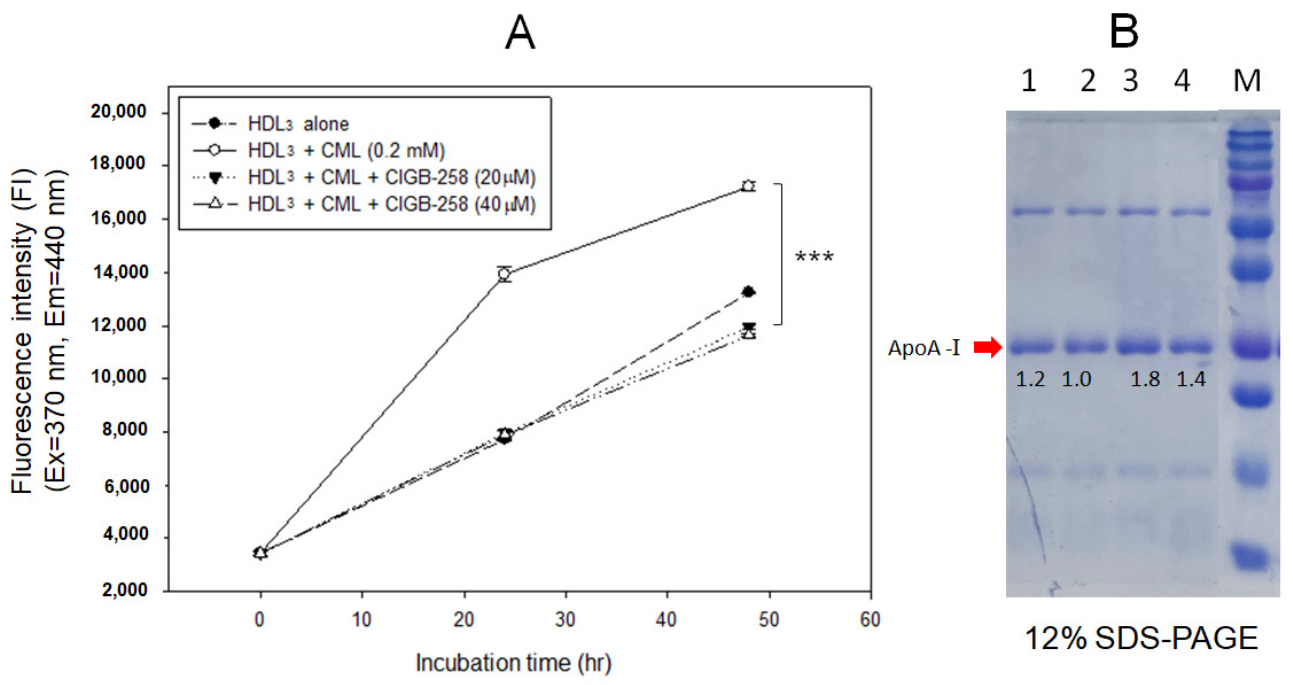
Figure 1. Glycation extent of high-density lipoproteins (HDL) by carboxymethyllysine (CML) in the presence and absence of CIGB-258. ( A ) Measurement of fluorescence intensity (Ex = 370 nm, Em = 440 nm) of HDL 3 to compare glycated extent during 48 h incubation. ***, p <0.001 between HDL 3 + CML and HDL 3 + CML + CIGB-258 (20 μ M). ( B ) Electrophoretic patterns of the HDL 3 after 48 h incubation (12% SDS-PAGE). Lane 1, HDL 3 (1 mg/mL) + PBS; lane 2, HDL 3 + CML (final 0.2 mM); lane 3, HDL 3 + CML (final 0.2 mM) + CIGB-258 (final 20 μ M); lane 4, HDL 3 + CML (final 0.2 mM) + CIGB-258 (final 40 μ M); lane M, molecular weight marker (Bio-Rad, prestained low-range). The protein bands were visualized by Coomassie Brilliant Blue staining.